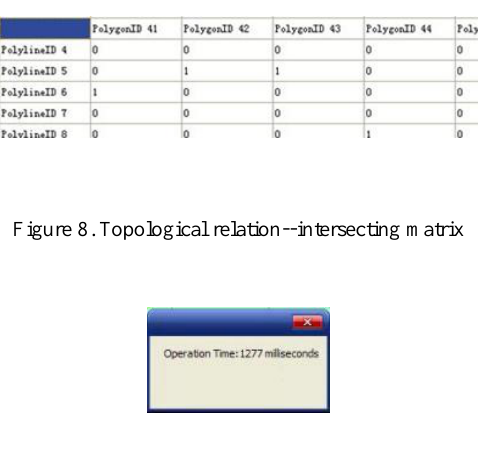
Figure 5. Unitization and numbering